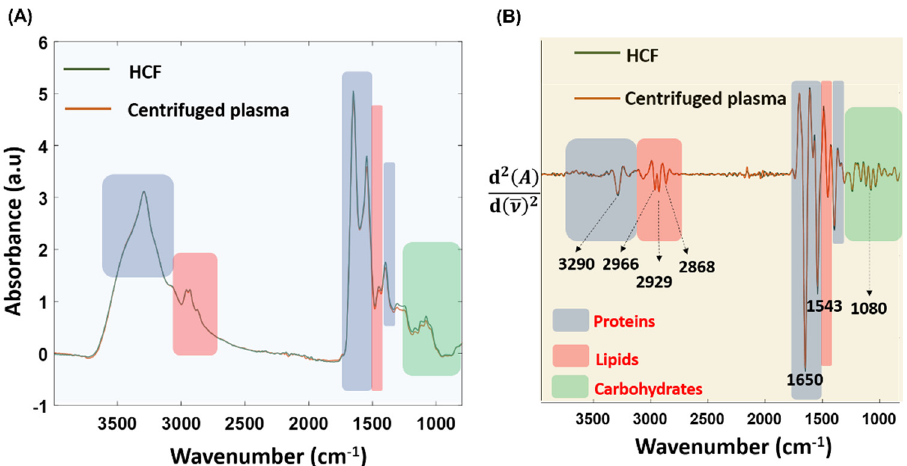
Figure 9. ( A ) The baseline-corrected and -normalized averaged spectra from HCF and centrifugation approaches. ( B ) Corresponding second-derivative spectra.